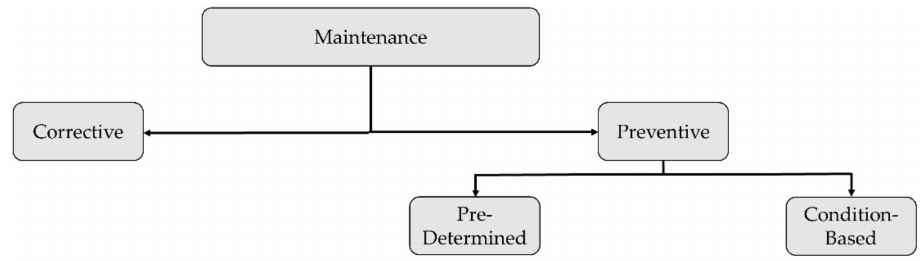
Figure 8. Maintenance strategies according to EN 13306:2017.